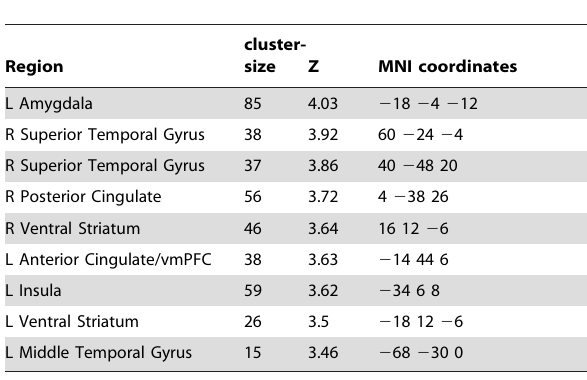
Table 4. Anatomical Site, Cluster Size, maximum Z value, and MNI coordinates of the local maxima for the connectivity analysis (seed in left ventral striatum [MNI coordinates 2 10 9 2 9], connectivity gamblers . controls, main effect across delay and probability discounting